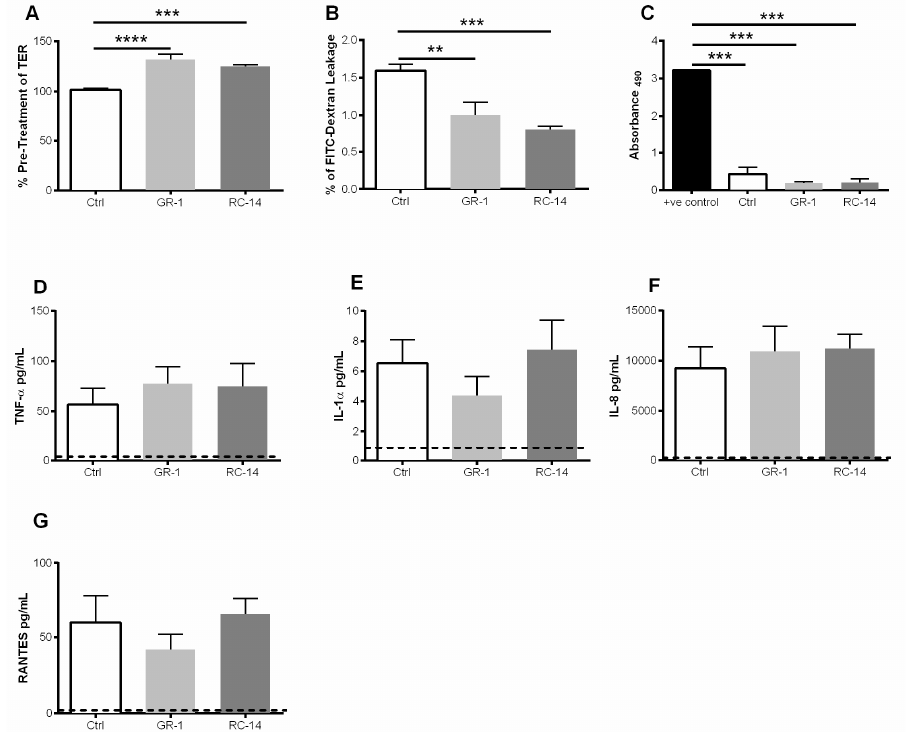
Figure 1. Exposure to probiotic strains of lactobacilli improves barrier function of primary genital epithelial cells and does not alter viability or production of pro-inflammatory cytokines and chemokines. Confluent monolayers of GECs were treated for 2 h with probiotic strains L. rhamnosus GR-1 and L. reuteri RC-14 abbreviated GR-1 and RC-14 respectively and / or no bacteria (Ctrl). After treatment, non-adherent lactobacilli were removed, and GECs were monitored for a further 24 h. ( A ) TER was measured pre-treatment and at 24 h post-treatment with lactobacilli. TER is expressed as percent of pre-treatment TER. ( B) Following treatment with bacteria, primary GECs were incubated with FITC-dextran dye on the apical surface, and FITC-dextran leakage in the basolateral compartment was measured after 24 h. Data are expressed as a percentage of FITC-dextran added to the apical compartment. ( C ) LDH release (Abs 490 ) by GECs 24 h after treatment with GR-1, RC-14 or no bacteria, or from GEC cultures lysed to release total LDH (positive control). ( D – G ) 24 h post-treatment with lactobacilli, cell supernatants were collected and analyzed for the presence of TNF- α , IL-1 α , IL-8, and RANTES. Dashed line indicates assay limit of detection. Data shown are representative of 6–9 separate experiments done on tissues taken from 6-9 di ff erent donors and shown as mean ± SEM. Each experiment had 3 replicate cultures for each experimental condition. Statistical significance is indicated as: **** p < 0.0001, *** p < 0.001, ** p <